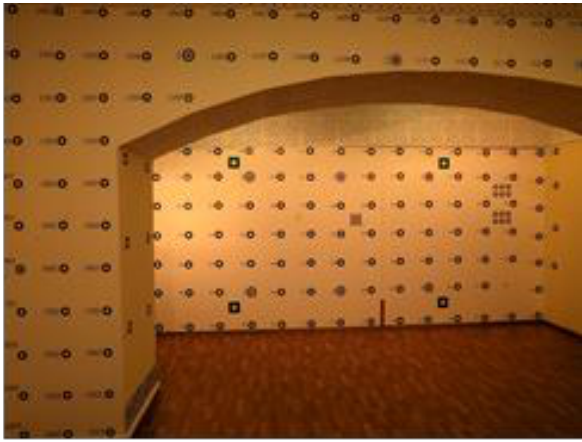
Figure 5. Examples of chessboards imaging